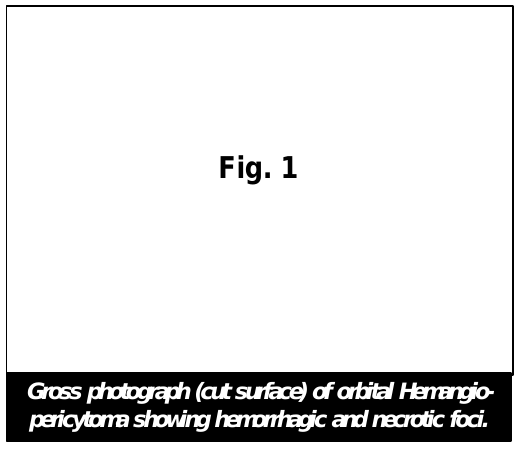
Gross photograph (cut surface) of orbital Hemangio- pericytoma showing hemorrhagic and necrotic